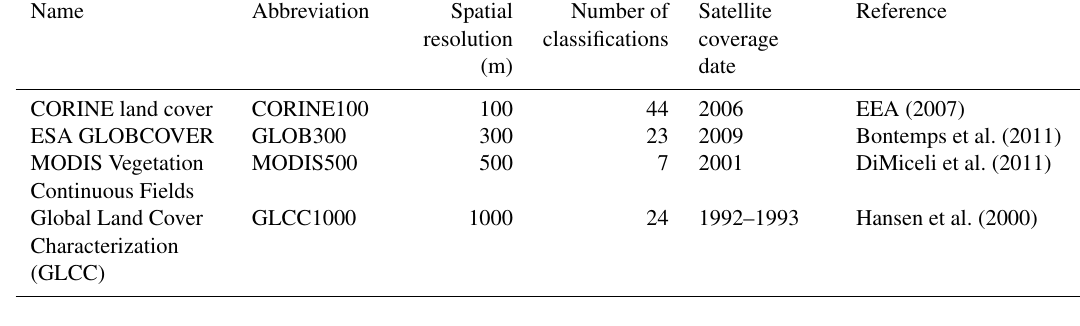
Table 2. Summary of the different land use data sources used for creating the roughness maps.